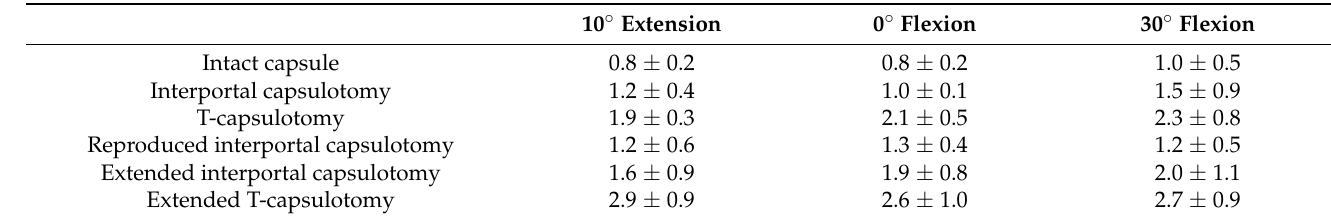
Table 1. Translation of the femoral head center of rotation as calculated by average root mean square of the difference of co-ordinate between external rotation and internal rotation at 2.5 Nm torque. Units in